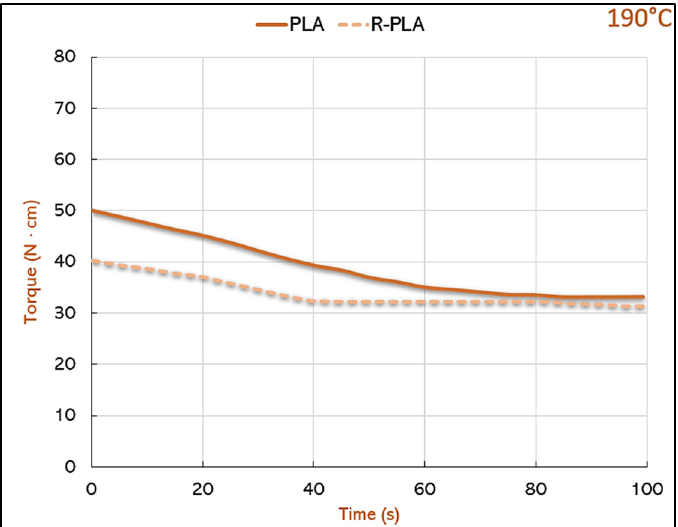
Figure 1. Torque trend for PLA and R-PLA.